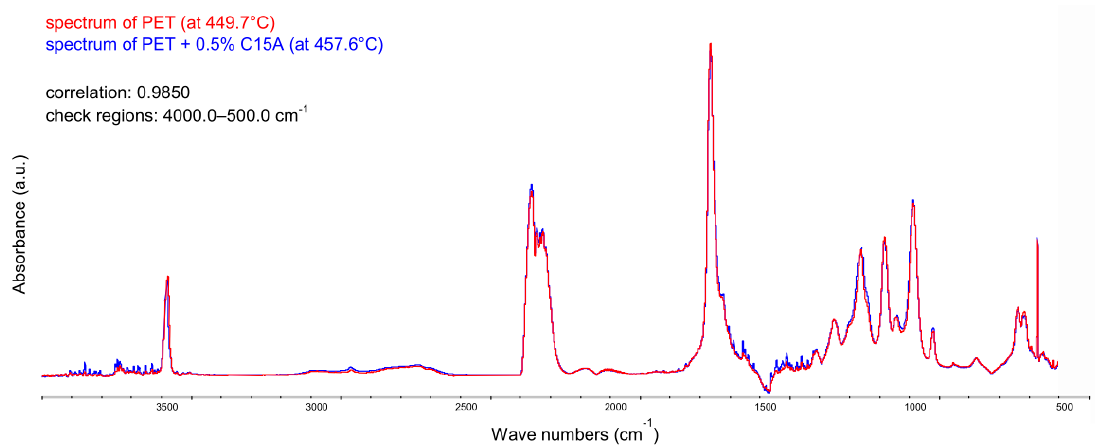
Figure 11. FTIR spectra recorded for pure PET (red) and PET modified with 0.5% C15A (blue) in the range of 500–4000 cm − 1 at temperatures characteristic of the first step of oxidative degradation process: 449.7 and 457.6 °C, respectively, determined on the basis of Gram-Schmidt curves.